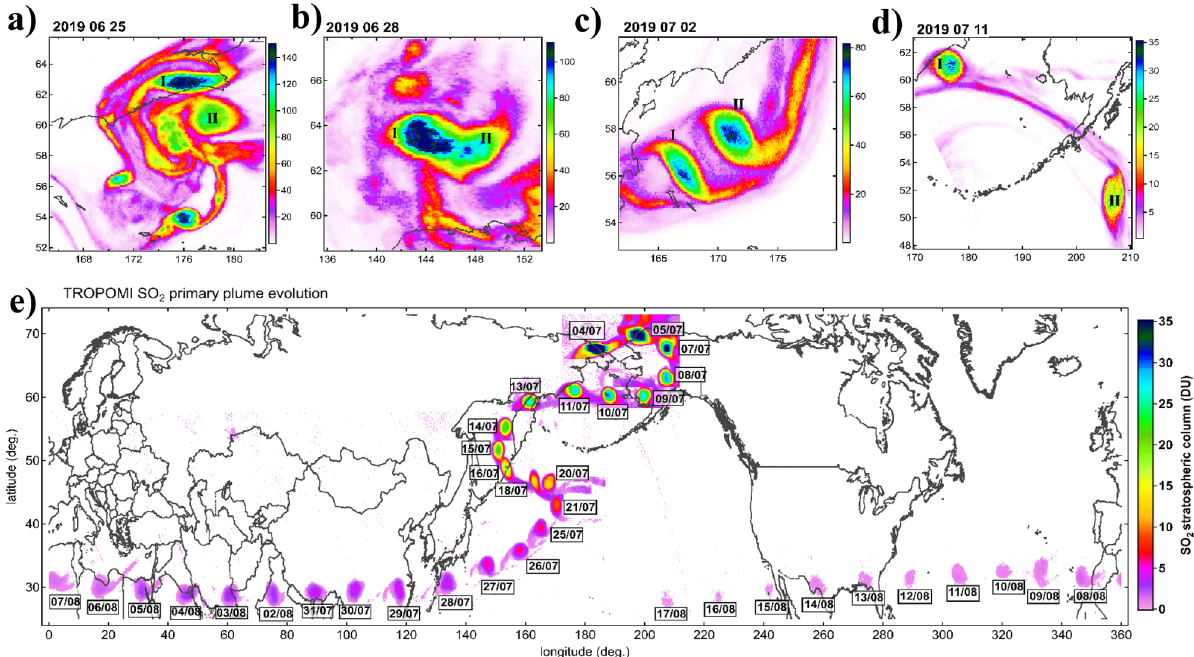
Figure 1. Evolution of the confined volcanic plume (structure I) from TROPOMI high-resolution mapping of SO2 stratospheric column in DU. ( a,b,c,d ) Early evolution of the Raikoke stratospheric SO plumes between 26 June and 11 July 2019. The two largest circular structures are denoted I and II. Note the different color scale of the panels. ( e ) Spatiotemporal evolution of the primary vortex (I). The dates in 2019 are denoted in dd/mm